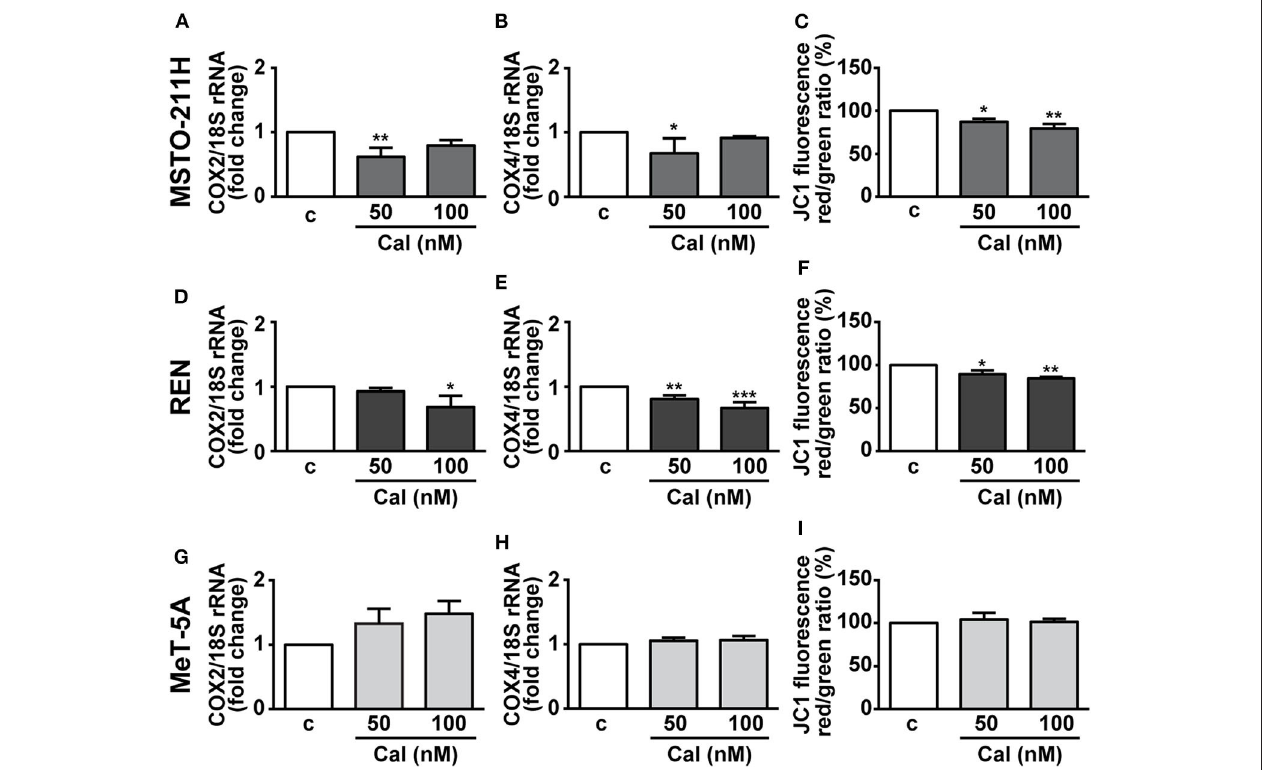
FIGURE 5 | Effect of calcitriol on mitochondrial metabolism in MPM cells. Real-time PCR for COX2 and COX4 mRNA expression in MSTO-211H (A,B) , REN (D,E) , and MeT-5A cells (G,H) , serum starved for 12h then treated for 24h with calcitriol (Cal) at the concentrations indicated. Results, normalized to18S rRNA are expressed as fold change of vehicle are means ± SEM. * P < 0.05, ** P < 0.01 and *** P < 0.001 vs. c; ns, not significant; n = 3. Mitochondrial membrane potential ( 1Ψ m) assessed by flow cytometry analysis of JC-1 in MSTO-211H (C) , REN (F) and MeT-5A cells (I) treated for 24h in medium with 1% serum (c, control medium), and either with or without calcitriol (Cal) at the concentrations indicated. Red to green (FL-2/FL-1) ratio was calculated in each experimental condition and expressed as percent of untreated cells. Results are means ± SEM. * P < 0.05, * P < 0.01 vs. c; n = 3.